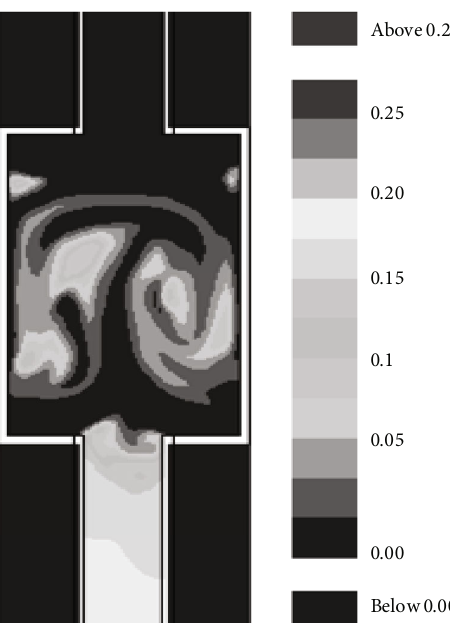
Figure 2: The simulation diagram of secondary fl ame formation in gas explosion in